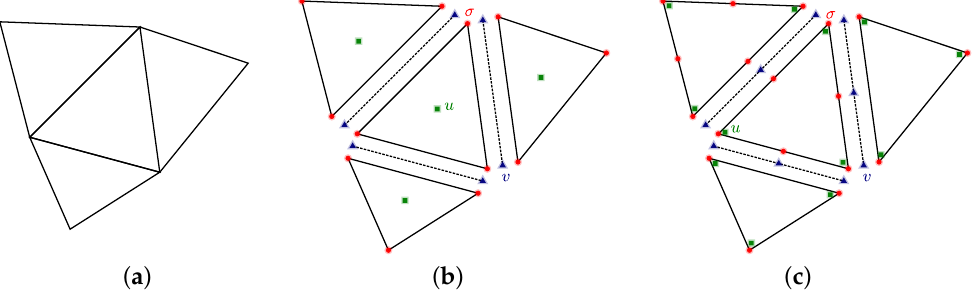
Figure 2. ( a ) geometrical 2D mesh; ( b ) mixed approach with p = 1; ( c ) mixed approach with p =